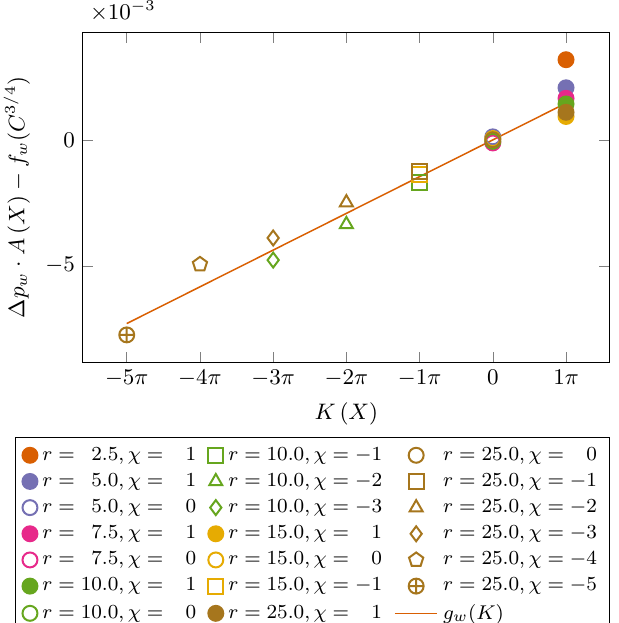
Figure 5. Dimensionless pressure difference between the continuous phase transition associated with adsorption of gas onto a wall in the bulk and inside a pore times the surface area Minkowski functional minus the function from Figure 4, ∆ p w · A ( X ) − f w ( C 3/4 ) , as function of the Minkowski functional, K ( X ) . The graph shows a collapse of the data and a linear fit with: g w ( K ) = κ (cid:48) = 4.6 × 10 − 4 ± 0.2 × 10 − 4 where κ (cid:48) lg